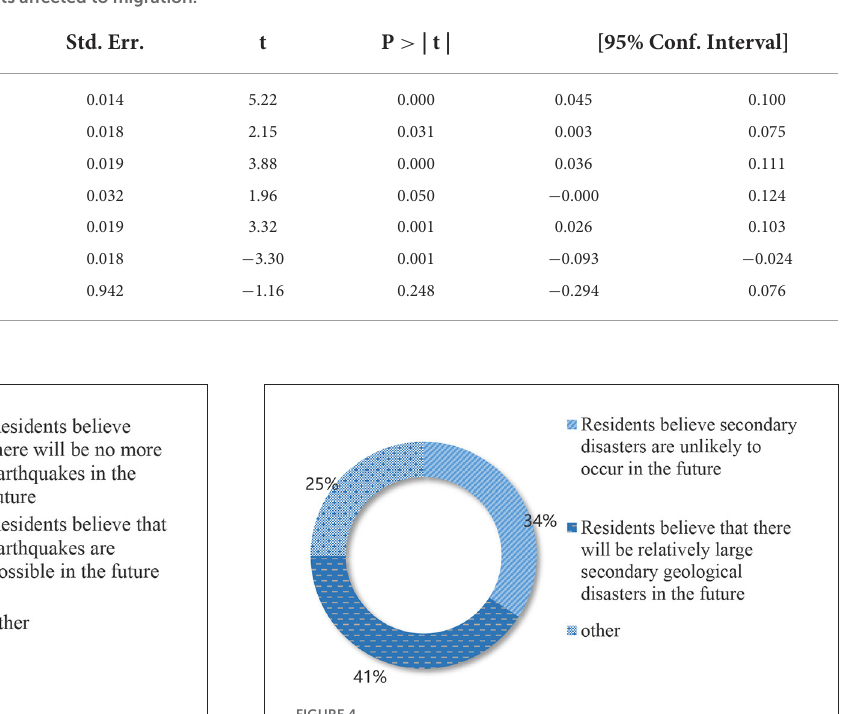
FIGURE3 Residents’ views on the prospect of an earthquake.